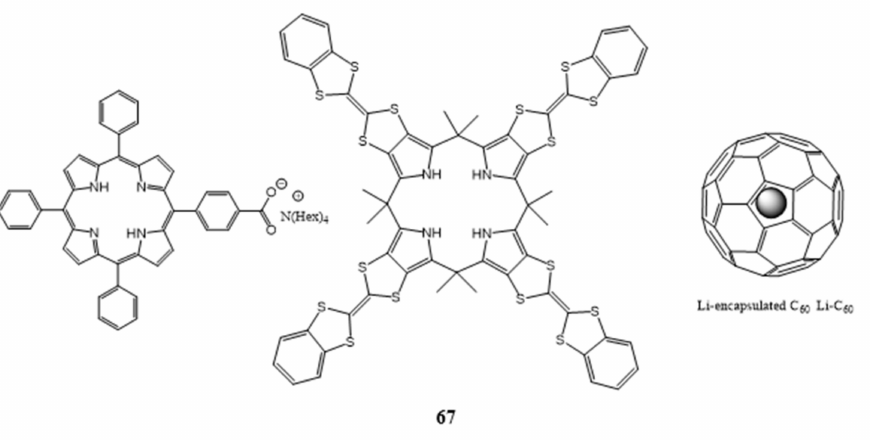
Figure 10. Structures of porphyrin salt, tetrathiafulvalenecalix[4]pyrrole ( 67 ), and Li + -C 60 .